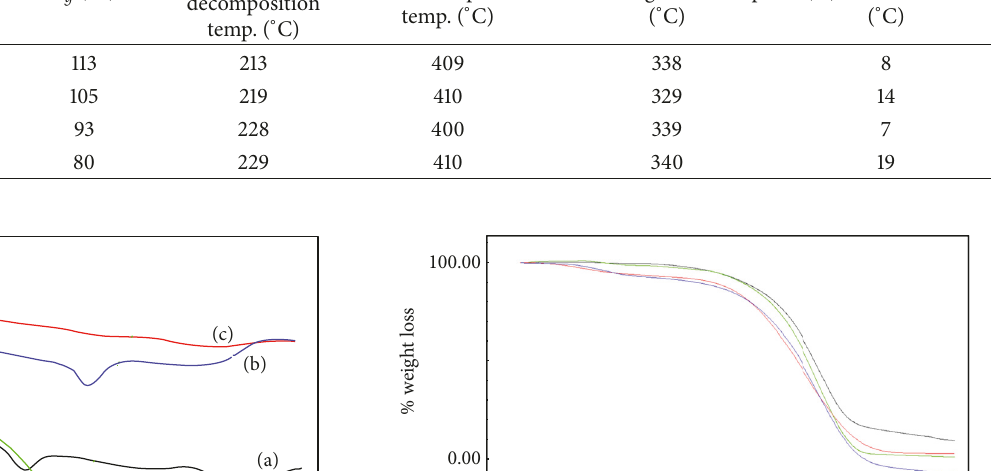
Figure 6: 1 H-NMR spectra of (a) P(DEAMSt0.11-co-MMA), (b) P(DEAMSt0.19-co-MMA), and (c) P(DEAMSt0.30-co-MMA). Table 2: TGA and DSC results of the P(DEAMSt) and P(DEAMSt-co-MMA). Polymer systems